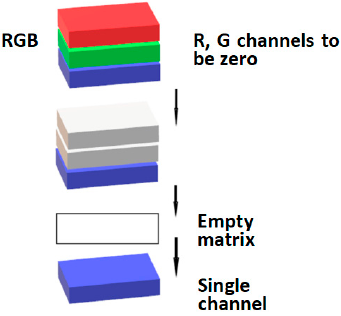
Figure 6. Single-channel acquisition process.